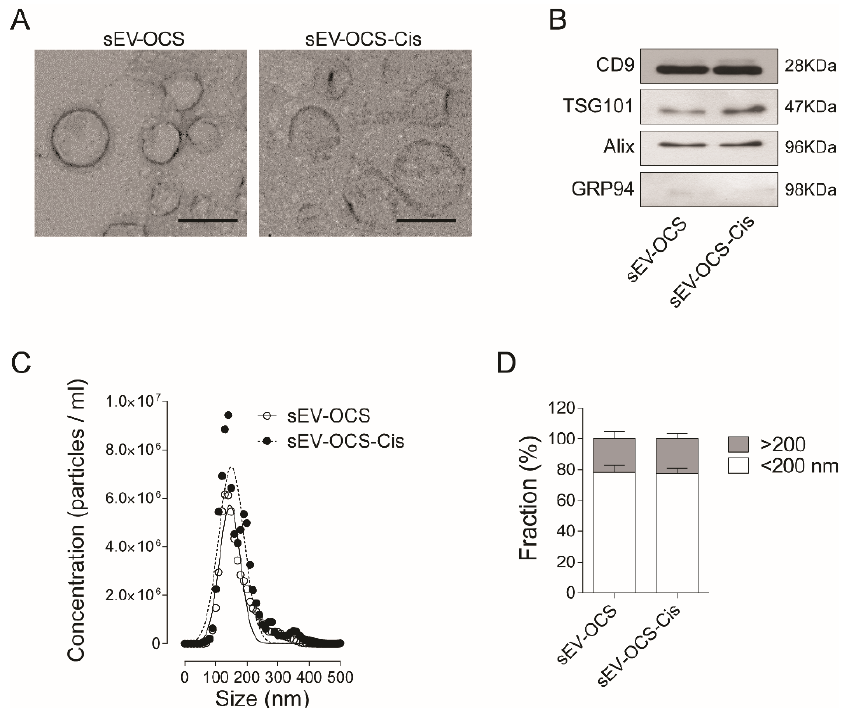
Figure 1. Characterization of small extracellular vesicles dervied from ovarian cancer spheroids (sEV-OCS) and sEV derived from OCS in response to cisplati (sEV-OCS-Cis). ( A ) Transmission electron microscopy of sEV-OCS-Cis (right panel) and sEV-OCS (left panel). Bar 100 nm. ( B ) Western blot of positive markers of exosomes (CD9, TSG101, Alix) in sEV-OCS and sEV-OCS-Cis. As a control of exosome purity, a marker of endoplasmic reticulum (GRP94) was used. ( C , D ) Distribution size of sEV-OCS (white circles) and sEV-OCS-Cis (black circles) measured by nanoparticles tracking analysis. Data represent the mean of three independent experiments .